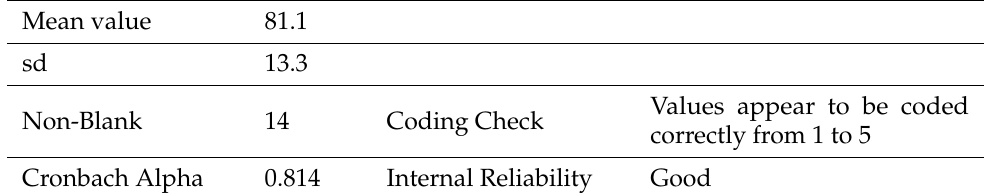
Table 11. Statistics SUS scoring and reliability